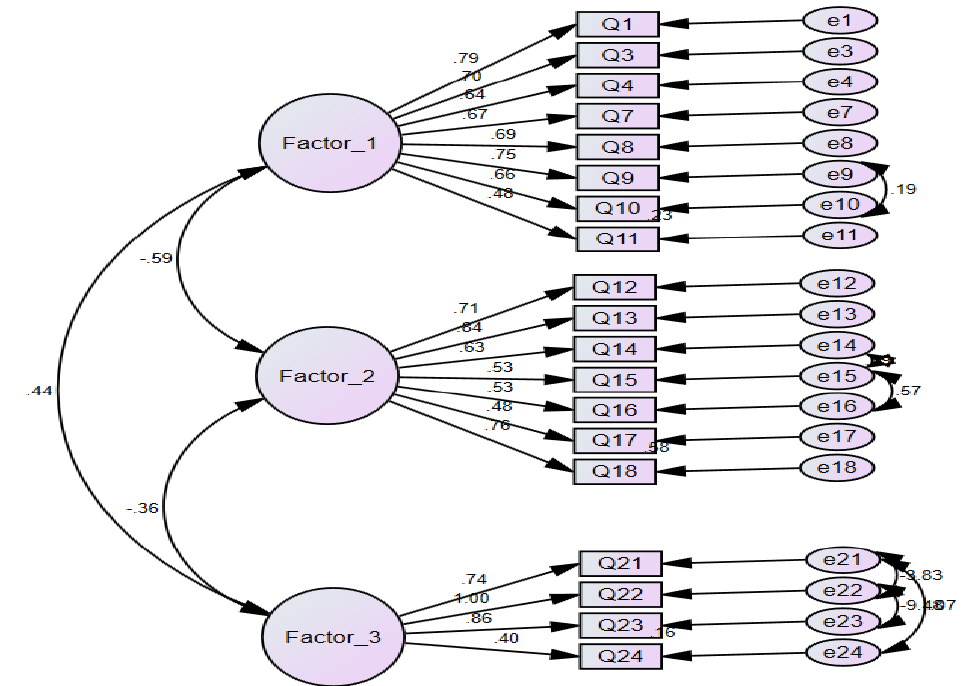
Figure 3. Confirmatory factor analysis of the PTIDB questionnaire.